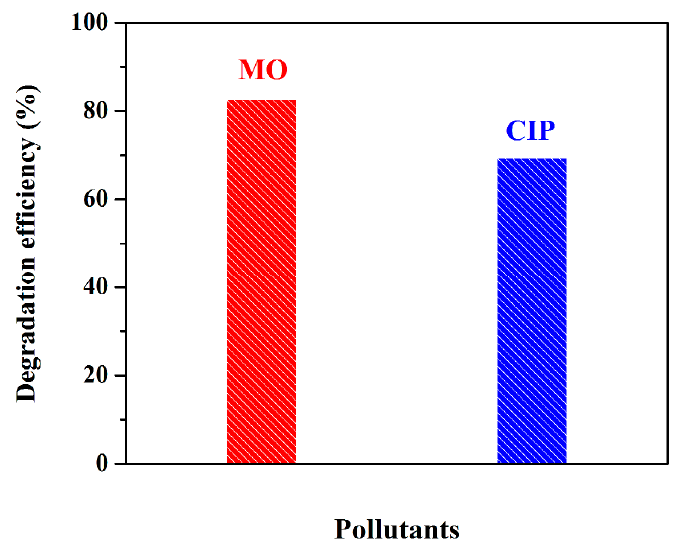
Figure 8. Photo-degradation efficiencies of MO (10 mg/L, 100 mL) and CIP (10 mg/L, 100 mL) aqueous solutions over Ag/Ag 2 CrO 4 /BiOCOOH within 50 min of simulated solar irradiation.